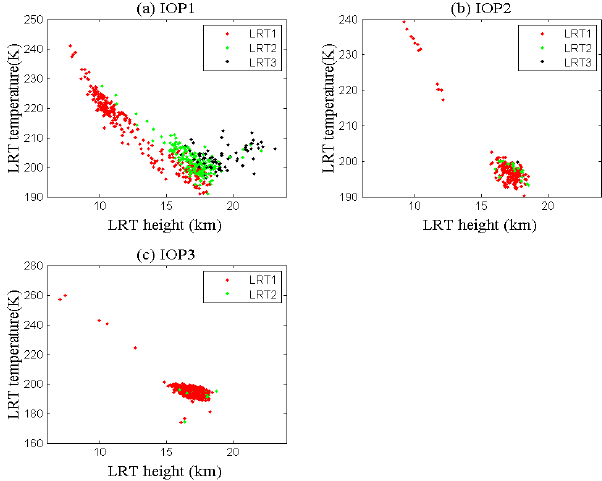
Fig. 4. Multi-tropopause heights versus temperatures. The first tropopause (LRT1), second tropopause (LRT2) and third tropopause (LRT3) are displayed by red, green and black colors separately. Table 1 lists which sites and data are analyzed in these three IOPs.